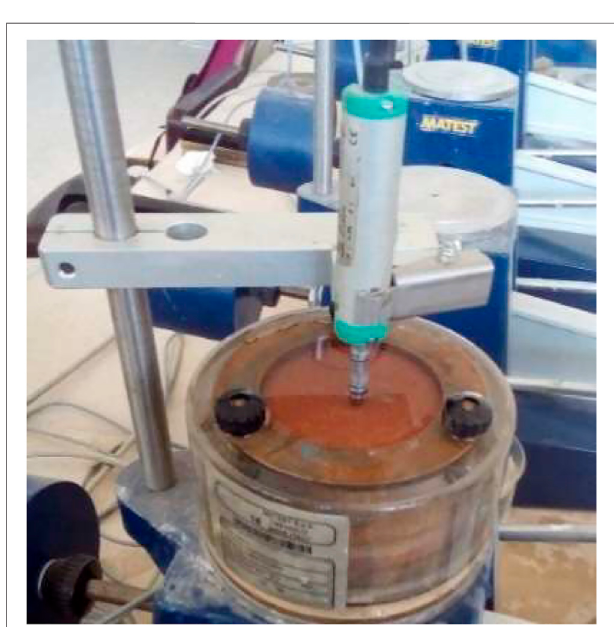
FIGURE 12 | Oedometer cell with displacement